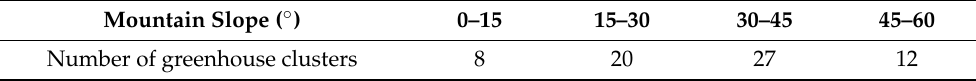
Table 3. The number of greenhouse clusters according to different mountain slopes.